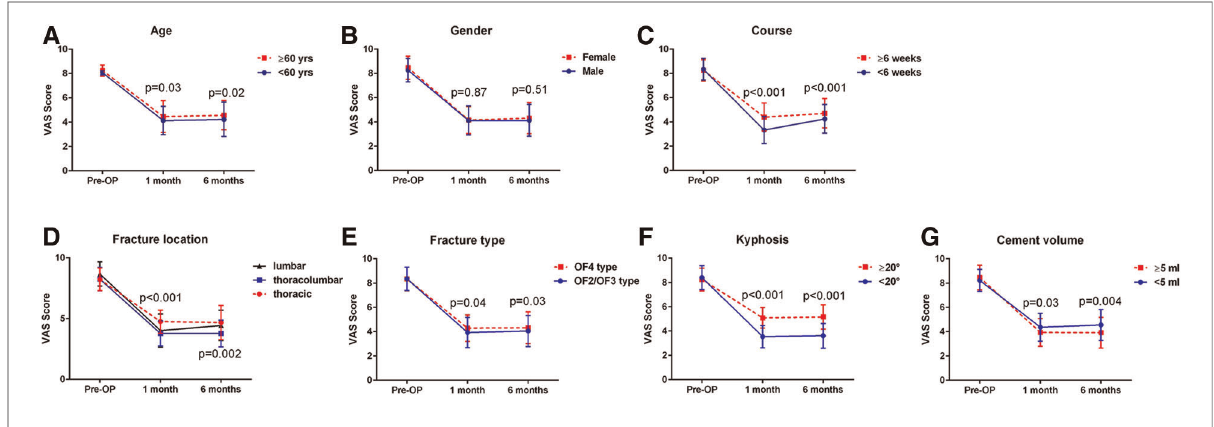
FIGURE 1 The effects of clinical characteristics on postoperative back pain at different follow-up point. ( A ), age; ( B ), gender; ( C ), course of disease; ( D ), fracture location; ( E ), fracture type; ( F ), segmental kyphosis; ( G ), cement volume.